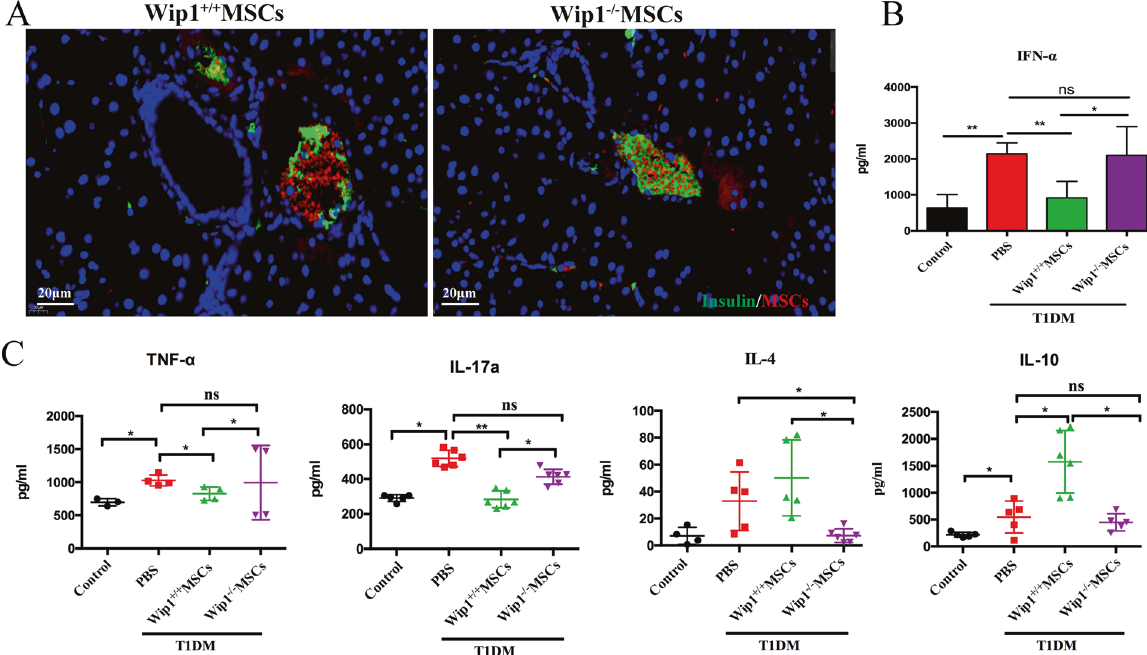
Fig. 6 IFN- α secreted by Wip1 − / − MSCs enhanced the in fl ammatory response in the pancreatic microenvironments of T1DM mice. A Immuno fl uorescence staining of pancreatic microenvironment including insulin (green), MSCs (red), and nuclei (blue) showed the size change of insulin and homing of MSCs in T1DM mice with an infusion of Wip1 + / + MSCs and Wip1 − / − MSCs. B , C Expression of IFN- α , TNF- α , IL- 17a, IL-4, and IL-10 in the pancreas by ELISA. Scale bar, 20 μ m. ( n = 7, three independent experiments) ns, not signi fi cant, * P < 0.05, ** P <